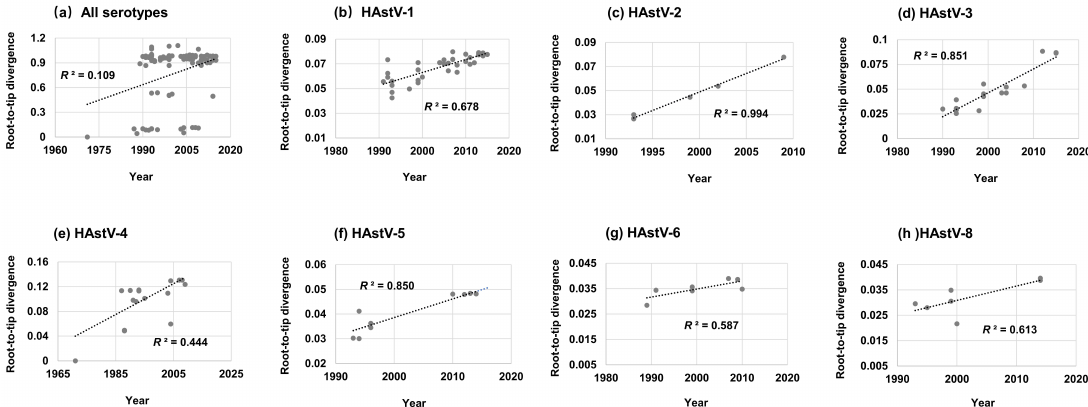
Figure 1. Root-to-tip divergence plots of the capsid protein gene of classic HAstVs: ( a ) all serotypes, ( b ) HAstV-1, ( c ) HAstV-2, ( d ) HAstV-3, ( e ) HAstV-4, (f) HAstV-5, ( g ) HAstV-6, and ( h ) HAstV-8. The Y -axis shows the root-to-tip divergence based on the maximum likelihood tree, and the X -axis indicates the isolation year. Each sequence is represented by a circle, and the dashed line indicates a linear regression line of the root-to-tip divergence and isolation